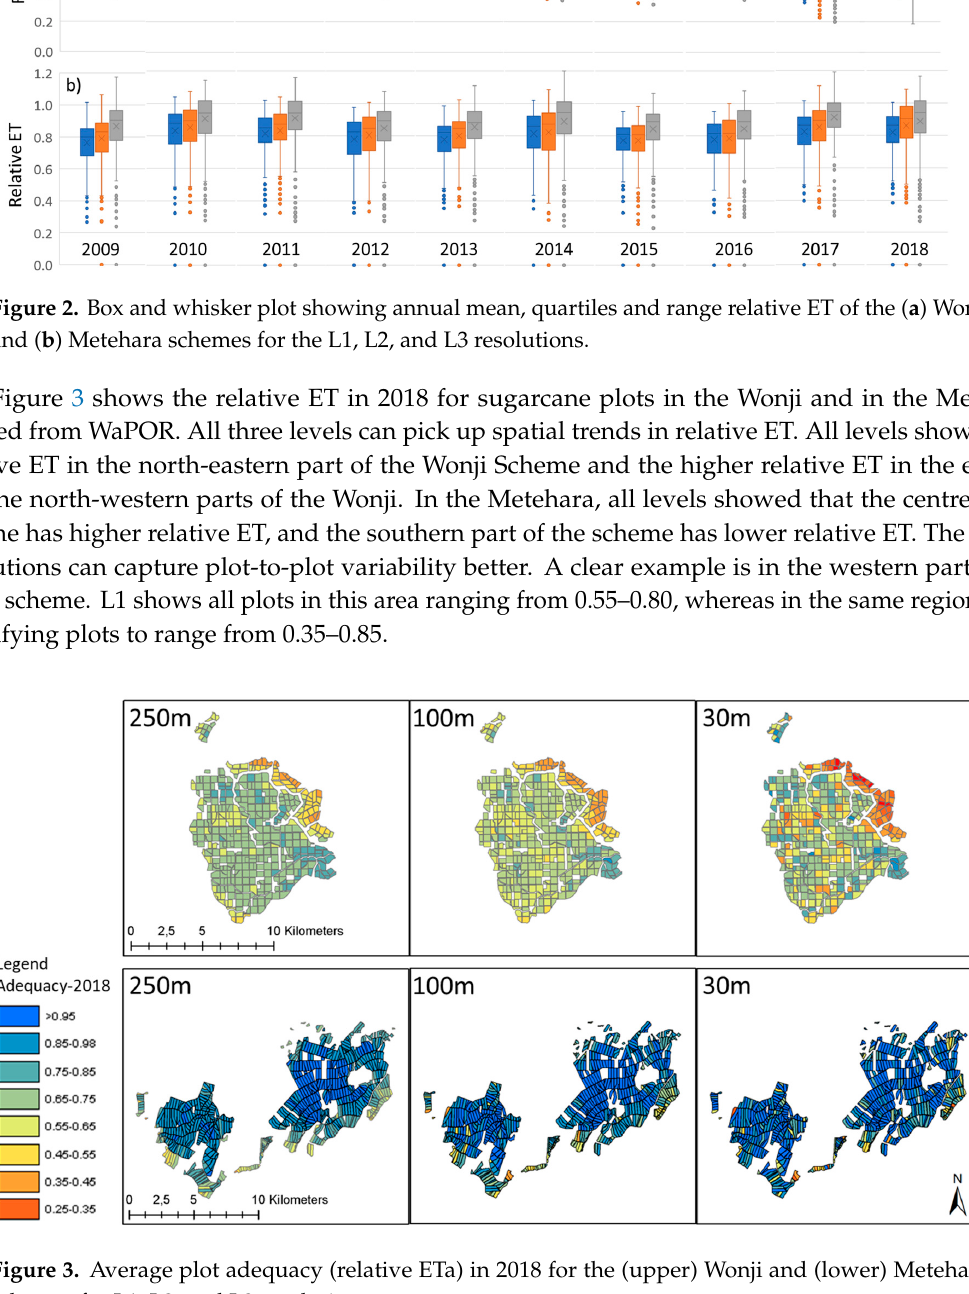
Figure 3. Average plot adequacy (relative ETa) in 2018 for the (upper) Wonji and (lower) Metehara schemes for L1, L2, and L3